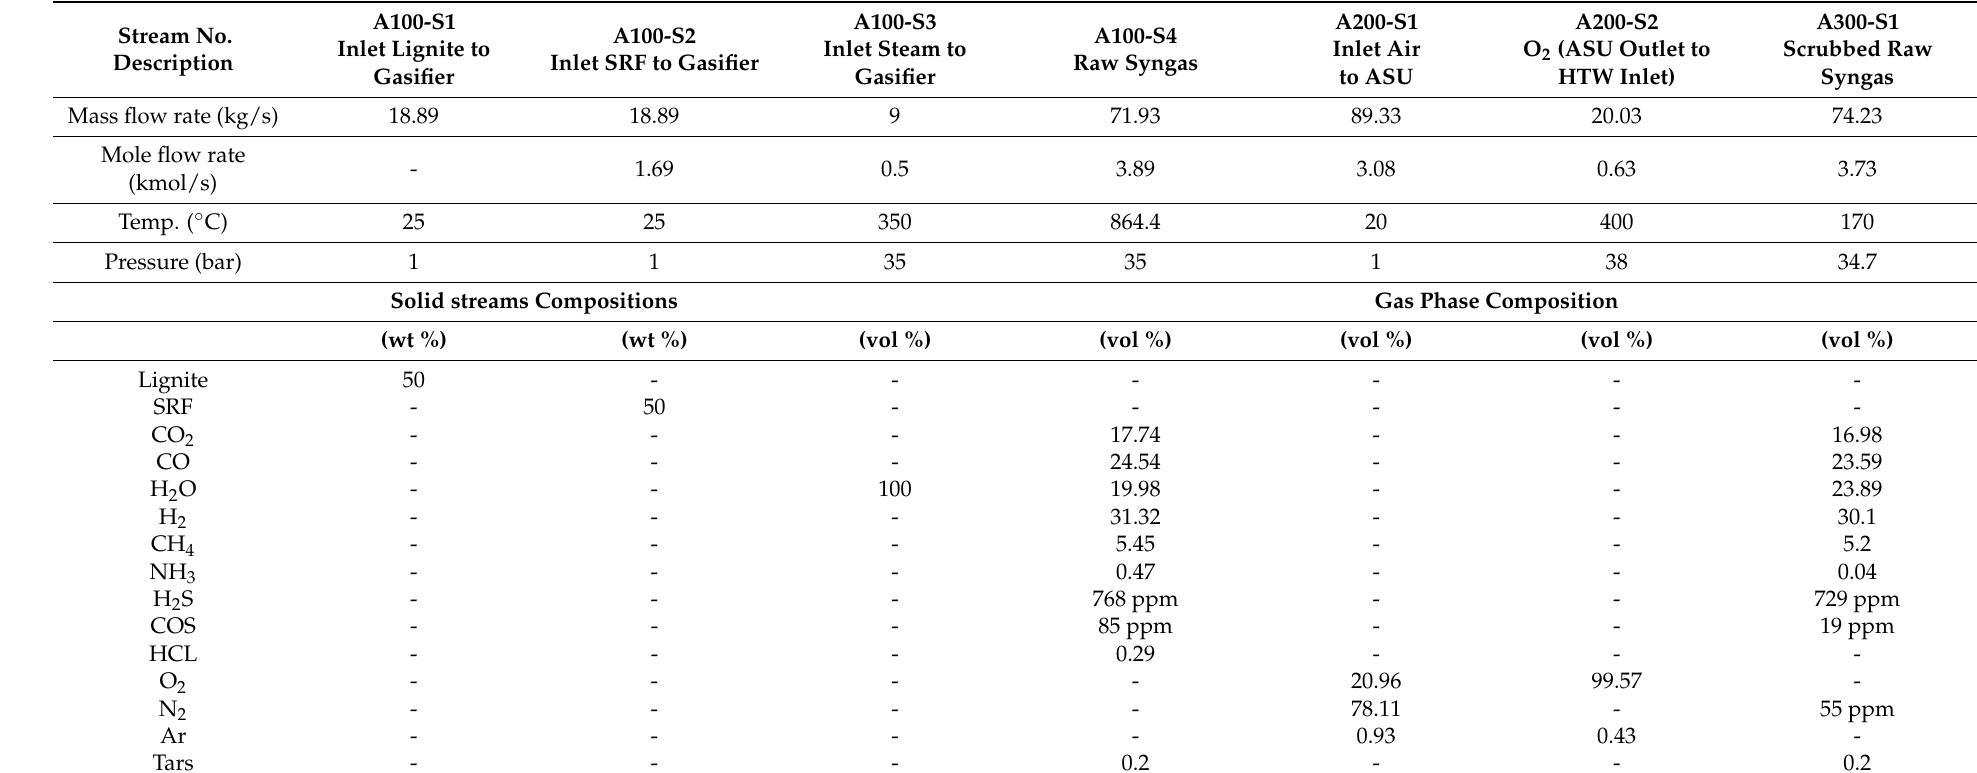
Table 7. Main stream results of the plant process for case 2 (50% LEG–50%